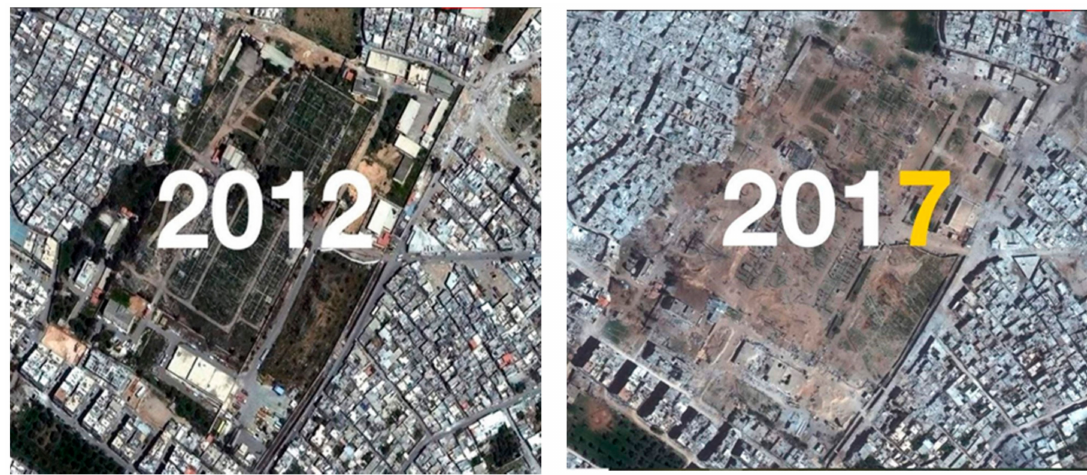
Figure 5. Damage to Kapoon substation in 2017 compared to 2012 [37].